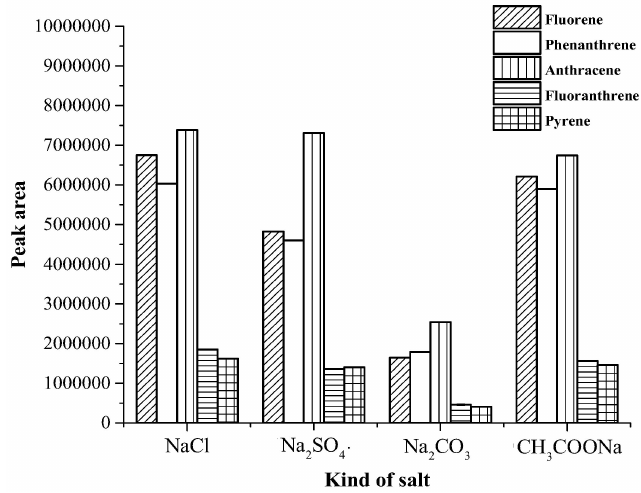
Figure 1. Effect of addition of salt on the extraction